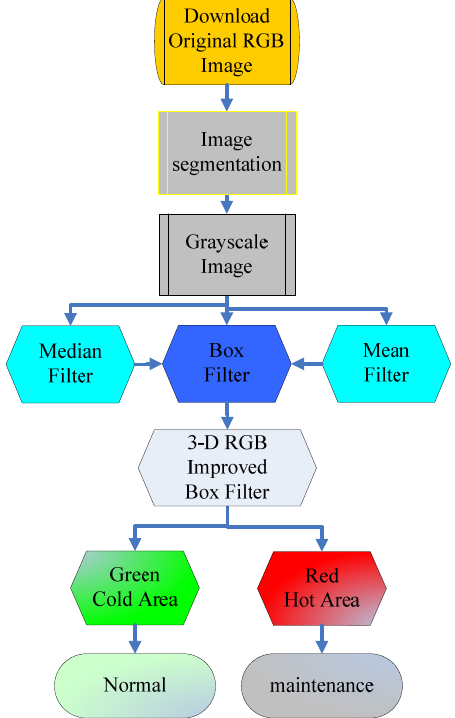
Figure 5. Flowchart of an image filtering